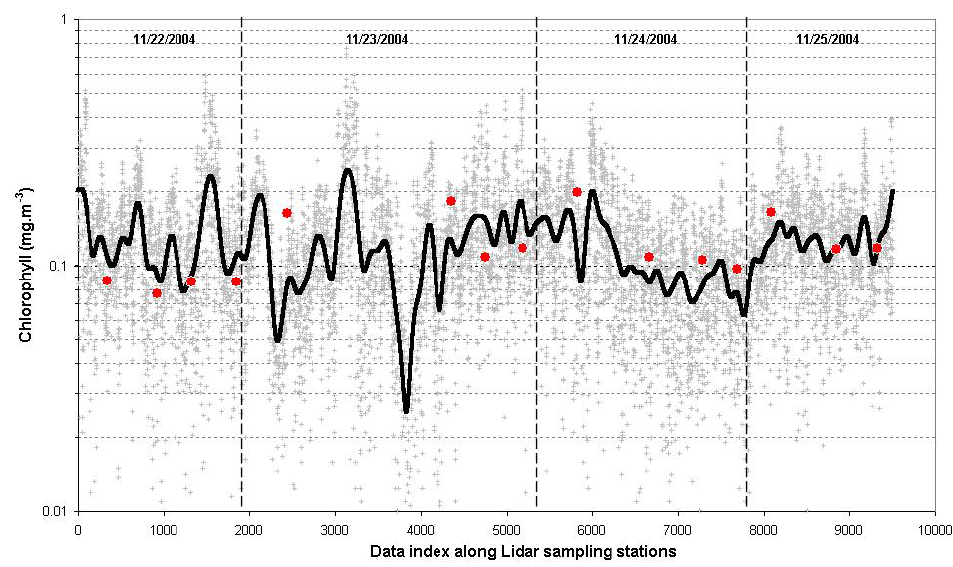
Figure 7. Surface chlorophyll concentration estimated with the along-track lidar sampling during the cruise FITOSAT I cruise, November 2004, in the Brazilian Southeastern continental shelf and slope compared with fluorometric estimates (grey crosses – Lidar measurements; black line – Lidar processed; red circles –